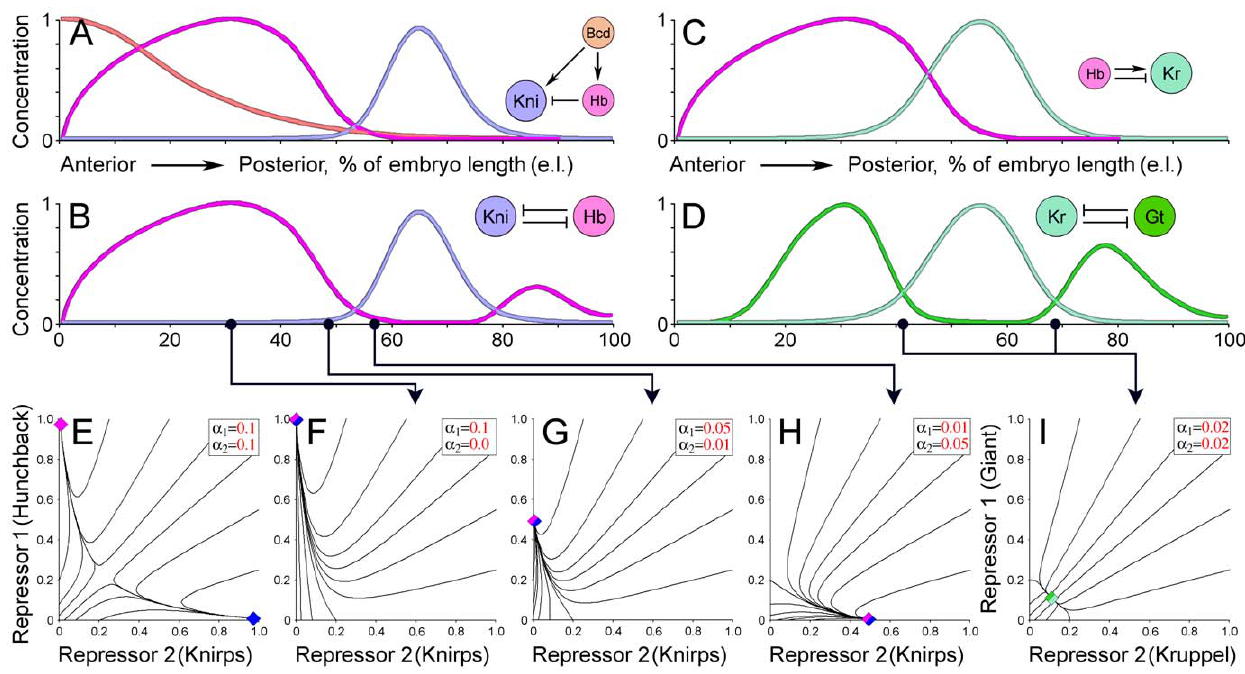
Figure 2. Positionally operated toggle switches. (A) Gradients for Bicoid (Bcd) and Hunchback (Hb) define positional potential (cue) for Knirps. (B) Relative distribution of mutually repressive Hb and Kni gradients. (C) Dual regulation by Hb defines positional cue for Kr. (D) Relative distribution of mutually repressive Giant (Gt) and Kruppel (Kr) gradients is similar to that of Hb and Kni (parallel module). (E) Phase portrait of a bistable toggle switch; the system has two dynamic attractors (diamonds) if rates of synthesis a 1 and a 2 (in red) are high. (F–I) Predicted behavior of a simulated toggle switch is in agreement (see the arrows) with the observed distribution of gap gradients in Hb-Kni and Gt-Kr pairs. If the synthesis rates a (positional cues) are asymmetric or low at a given coordinate, the toggle switch has a single attractor at that position.